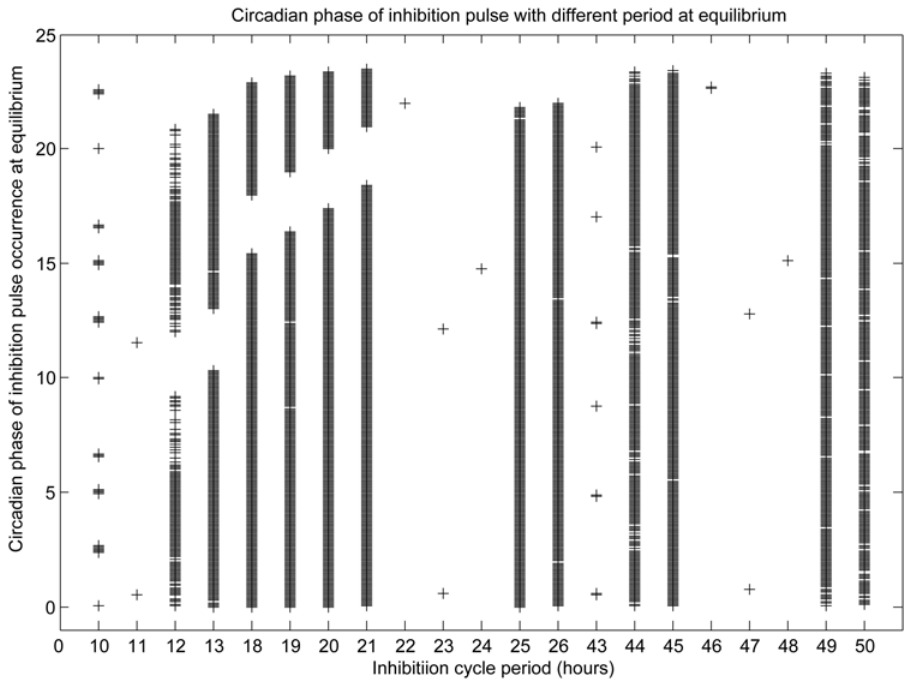
Figure 3. Steady state circadian phases of cell cycle M-phase. The cell cycle M-phase is introduced into the mammalian circadian model as transcriptional inhibition cycles of different periods. For each period, transcriptional inhibitions are imposed at various circadian phases with an interval of 30 minutes. The resulting models are simulated. Simulation data are sampled at equilibrium state and the circadian phases where cell cycle M-phase is located are calculated for each simulation. The calculated phases are combined and plotted against transcriptional inhibition periods.